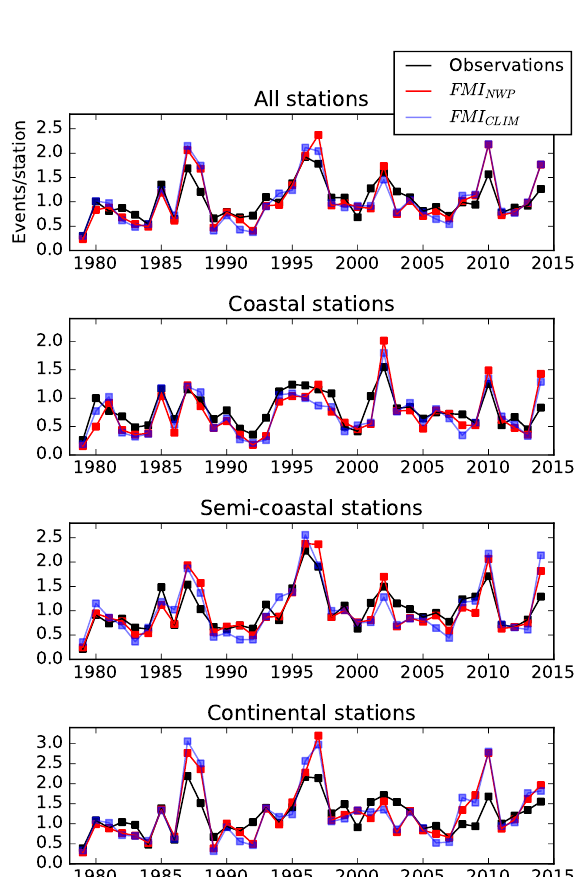
Figure 3. Annual, spatially averaged mean number of FZRA cases per station in all 293 stations and in groups based on distance to the nearest coastline according to SYNOP observations (black), the FMI NWP (red), and the FMI CLIM (blue) algorithm. Definitions of groups can be seen in Fig. 1. Statistics calculated from the numbers presented here are shown in Table 3. Note the different y axis